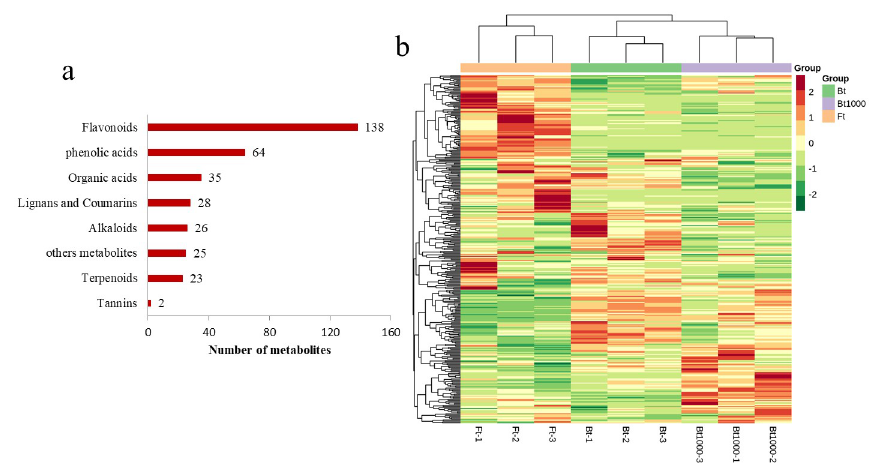
Fig 2. Number and heat map of metabolite profiles of different varieties. (a) Numbers of different types of metabolites in all samples. (b) Clustering heat map of the metabolites detected in the total samples. Each example is visualized in a single column, and each metabolite is represented by a single row. Red indicates high abundance, whereas low relative metabolites are shown in green. Ft indicates the flowering type, Bt indicates closed bud type and Bt1000 indicates MeJA-treated closed bud type (Bt1000).